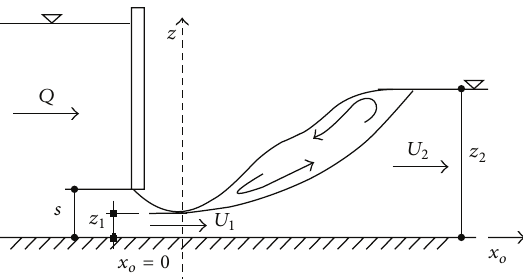
Figure 1: Definition sketch of free hydraulic